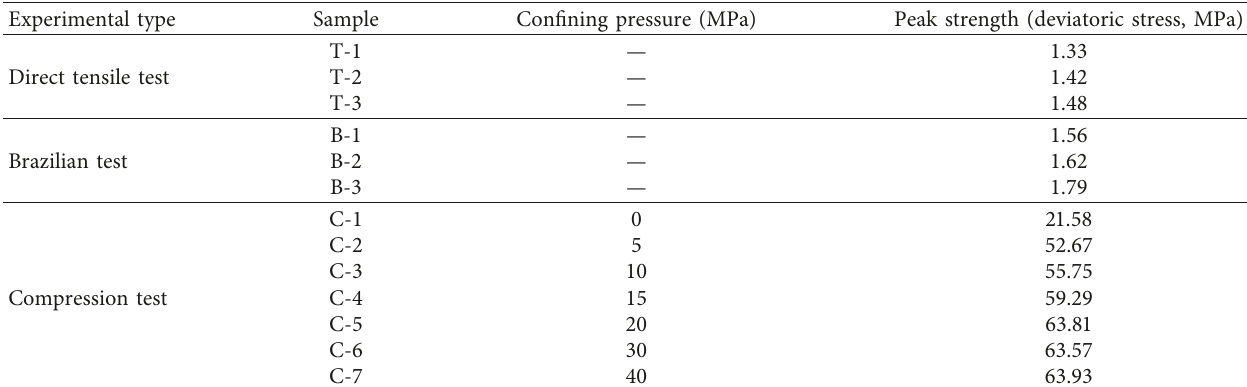
Figure 1: Illustration of rock samples for different tests. (a) Sample for the Brazilian test. (b) Sample for the direct tensile test. (c) Sample for the compression Table 1: Experimental results from different tests.